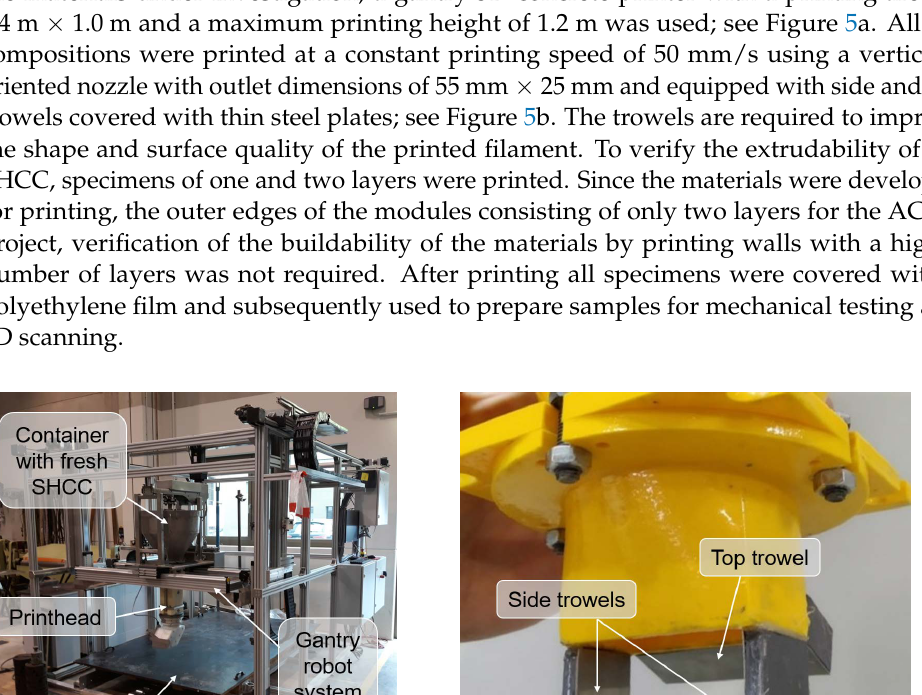
Figure 4. Test setups to assess the adhesiveness of SHCC: ( a ) tack test, ( b ) cylinder pull test, and ( c ) inclined table test.